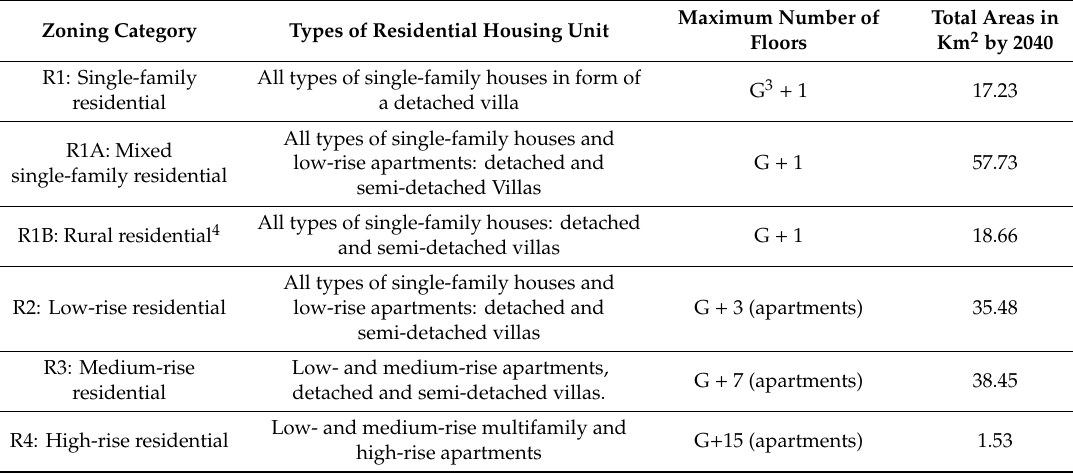
Table 3. Zoning regulations in Kigali city according to the masterplan for the period 2019–2040. Data source: